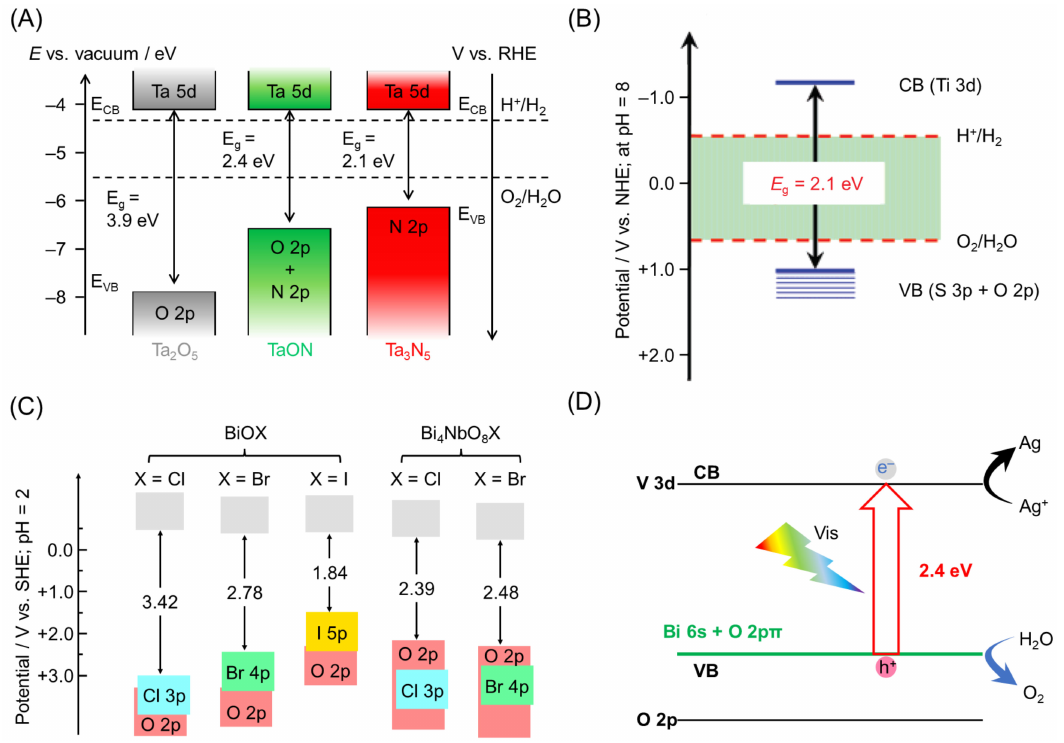
Figure 8. ( A ) Band diagrams for Ta 2 O 5 , TaON, and Ta 3 N 5 showing the shift in VBM upon nitridation. RHE represents the reversible hydrogen electrode. ( B ) Schematic illustration of band edge potentials of Sm 2 Ti 2 S 2 O 5 . ( C ) Schematic illustration of VB and CB structures of BiOX (X = Cl, Br, or I) and Bi 4 NbO 8 X (X = Cl or Br). Red, blue, green, and orange boxes represent the bands from O 2p, Cl 3p, Br 4p, and I 5p orbitals, respectively, and the gray box shows a CB composed mainly of Bi 6p. ( D ) Band structures of m -BiVO 4 . Reproduced with permission from references [86,92,99,109]. Copyright 2015 American Chemical Society, 2007 American Chemical Society, 2017 American Chemical Society, and 2009 The Royal Society of